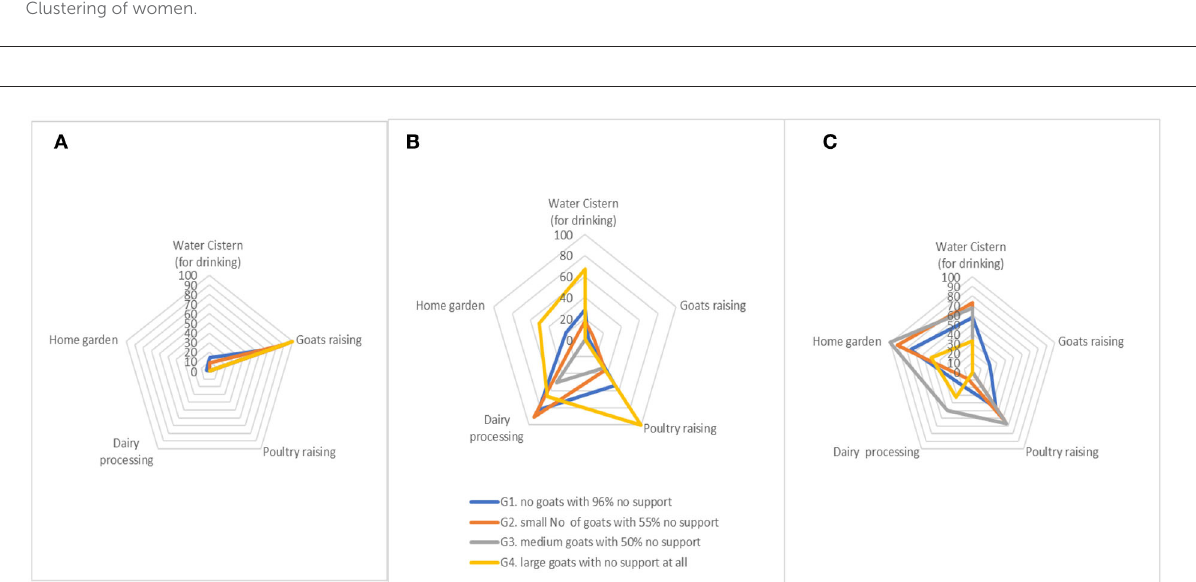
FIGURE10 Need assessment classified in (A) high, (B) low, and (C) no priority by women.